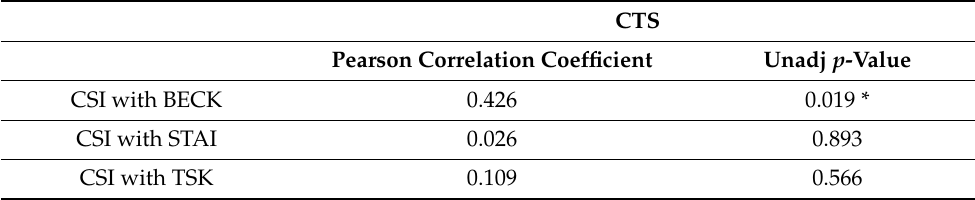
Table 5. Correlations between CSI and emotional